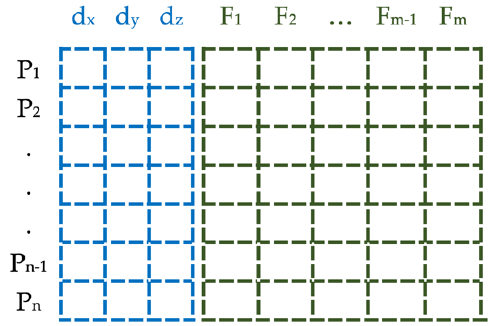
Figure 3. 2D patches generated for each 3D point of the cloud: P n denotes points, d x,y,z denotes patch-wise scaled coordinates (blue cells) and F m denotes the available/computed features (green cells).